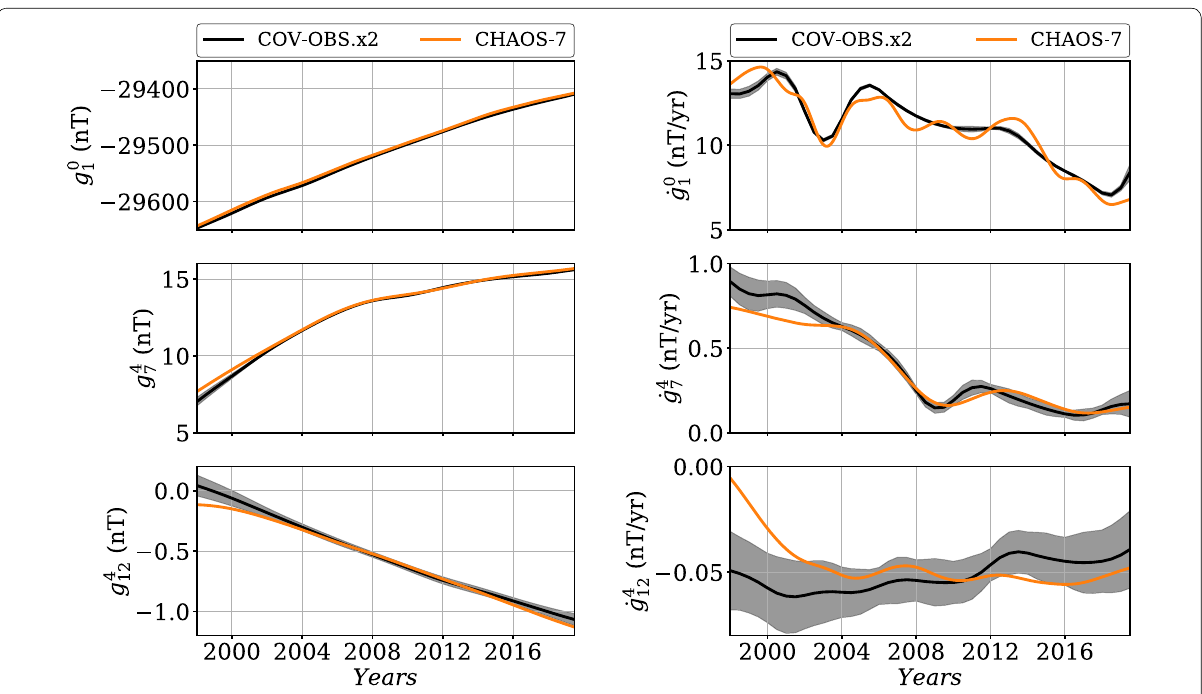
Fig. 5 MF (left) and SV (right) time series of g 0 1 (top), g 4 7 (middle) and g 4 12 (bottom) for COV-OBS.x2 (black), compared with CHAOS-7 (orange) between 1998 and 2020. The gray-shaded areas represent the ± σ dispersion within the ensemble of COV-OBS.x2